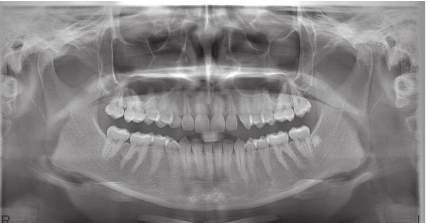
Figure 2: Panoramic radiograph showing the absences of right per- manent maxillary canine and all third molars. The deciduous canine is persisting with external root resorption. Note the radiopaque lesion in the left mandibular third molar region.